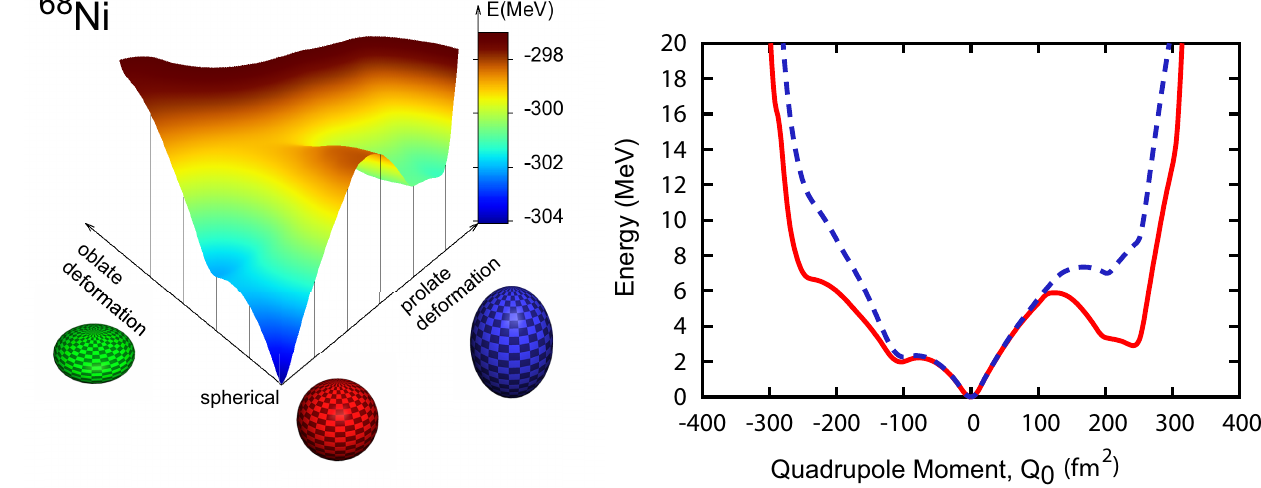
Figure 11. Left : Potential energy surface (PES) of 68 Ni. Taken from Figure 5 of [24]. Right : PES of 68 Ni with axially symmetric shapes. The solid line shows the PES of the full Hamiltonian, whereas the dashed line is the PES with practically no tensor-force contribution. Taken from Figure 6 of